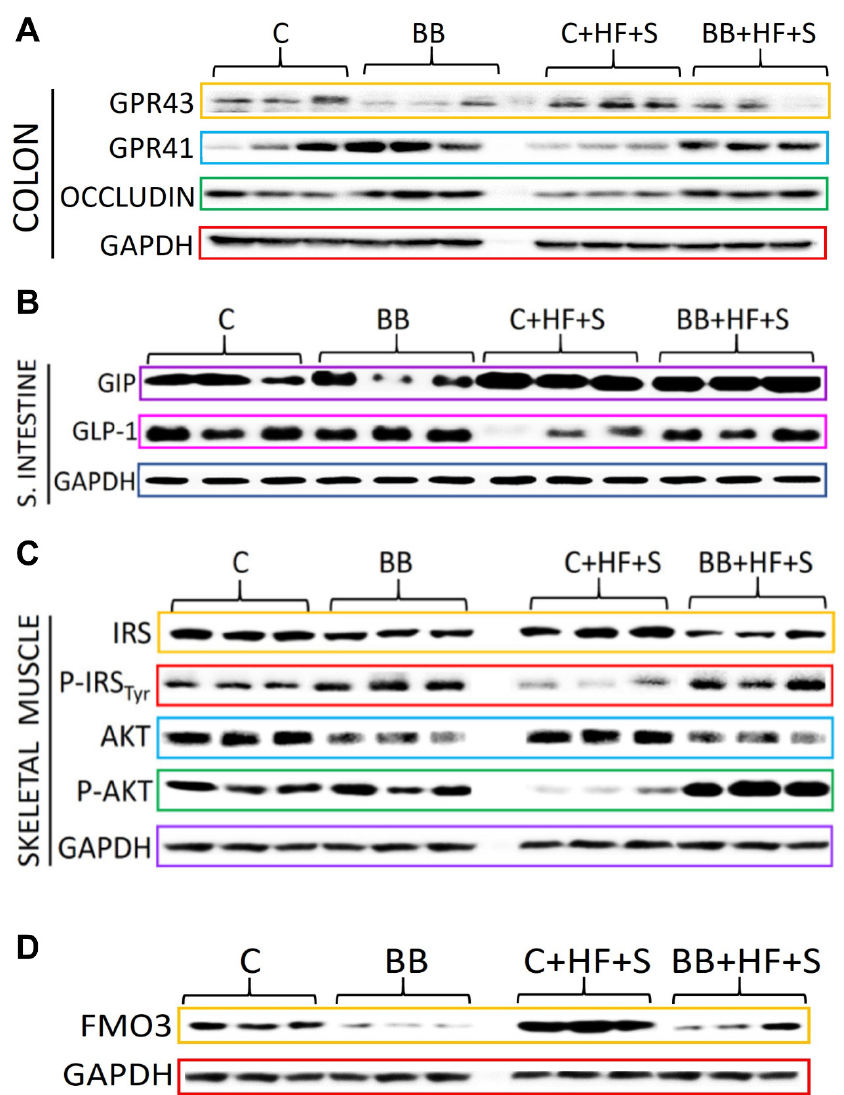
Figure 5. Black bean consumption maintains intestinal integrity and insulin signaling after an acute metabolic challenge with glucose. ( A ) Western blot analysis of small intestinal G-protein-coupled receptors (GPR43 and GPR41) and occludin. ( B ) Intestinal GIP, GLP-1, ( C ) skeletal muscle IRS, phosphorylation of IRS-1 at Tyr 896 , AKT, phosphorylation of AKT at Ser 473 ( D ) Hepatic flavin monooxygenase 3 (FM03) after 2 months of dietary treatments with casein [C], black bean [BB], Casein + high-fat + S 5% [C + HF + S], BB + HF + S. Four rats of each group were injected with 2 g / kg body weight of glucose and killed 30 min